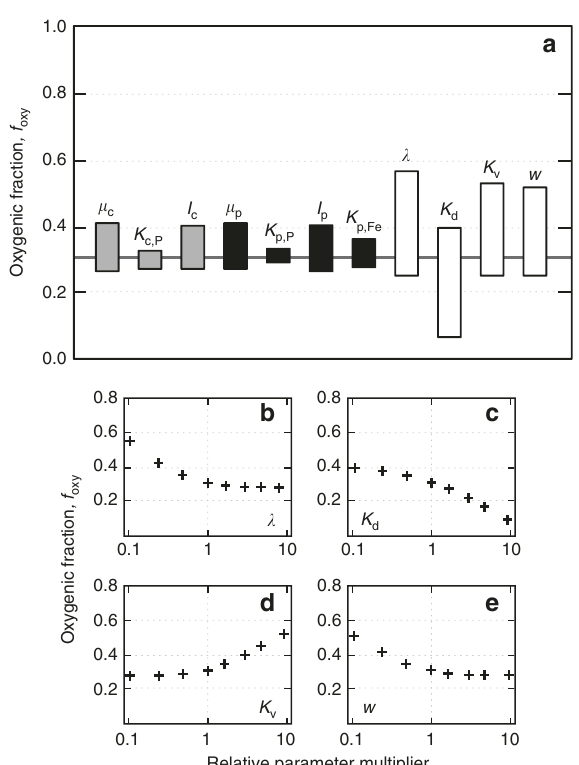
Fig. 5 Sensitivity analysis of the 1-D competitive photosynthesis model. Shown in a is the response of our principle diagnostic parameter, the fraction of overall photosynthesis performed by oxygenic phototrophs ( f oxy ), to varying each metabolic and physical parameter of the model by an order of magnitude above and below the value in the default parameter set (shown by the black horizontal line and denoted by the open circle in Fig. 4). Major metabolic parameters are maximum growth rates ( µ i ) and half-saturation constants for light ( I i ) and nutrients ( K i ,P ) for oxygenic phototrophs and photoferrotrophs (subscripts c and p, respectively). Physical parameters include light attenuation constant ( λ ), distribution coef fi cient for scavenging/coprecipitation of phosphorus on iron oxides ( K d ), eddy diffusivity ( K v ), and upwelling rate ( w ). Shown in b – e are sensitivity ensembles for physical parameters, with relative oxygenic phototrophy plotted as a function of relative forcing of each